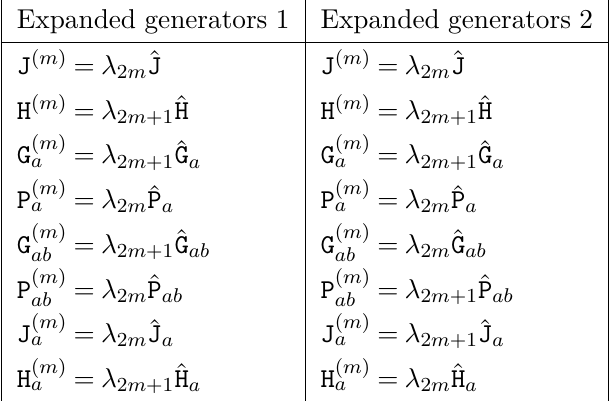
Table 4 . Ultra-relativistic expanded generators in terms of the relativistic spin-3 AdS generators. the ultra-relativistic generators are related to the relativistic ones through the semigroup